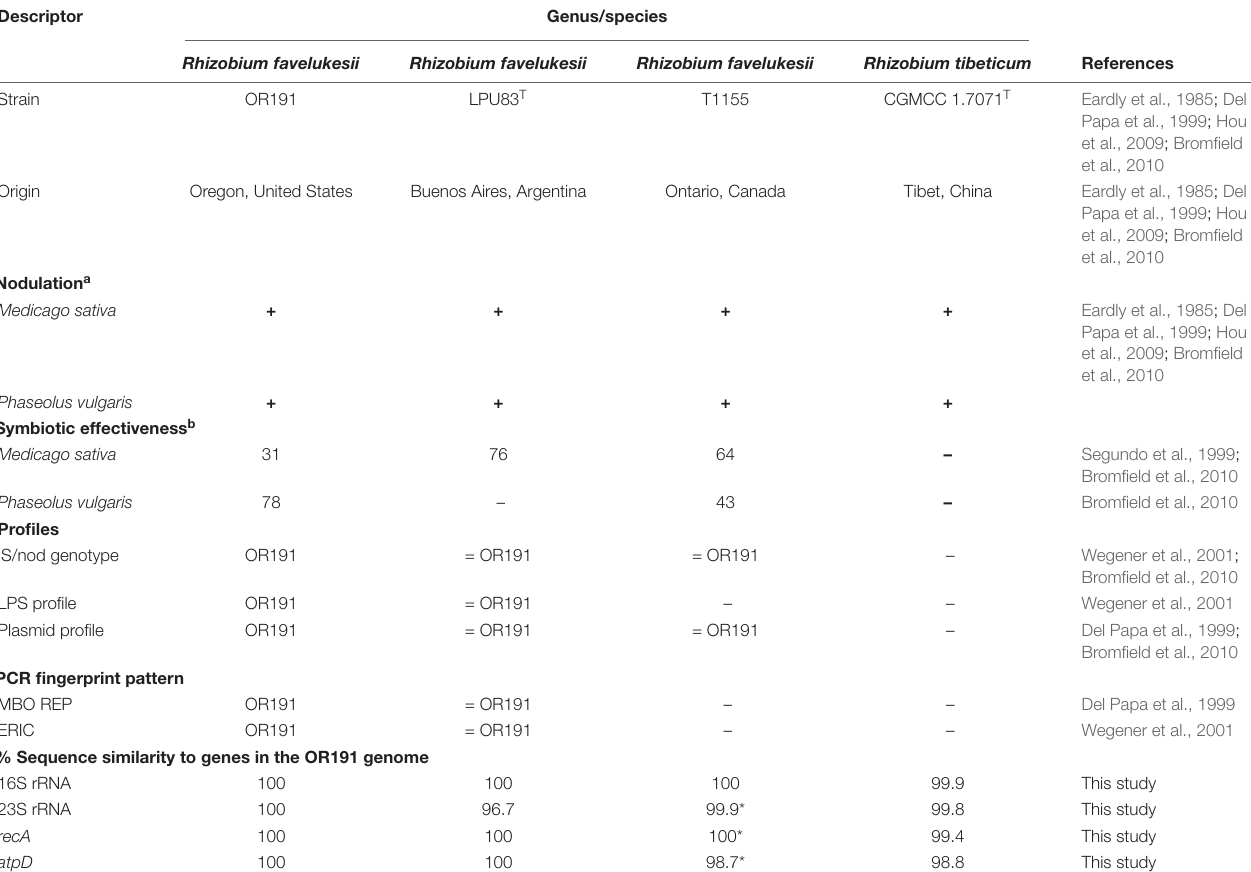
TABLE 2 | A descriptive summary of the phenotypic and genotypic characteristics of Rhizobium favelukesii OR191 compared to three other closely related Rhizobium strains that have the same extended host range as OR191.